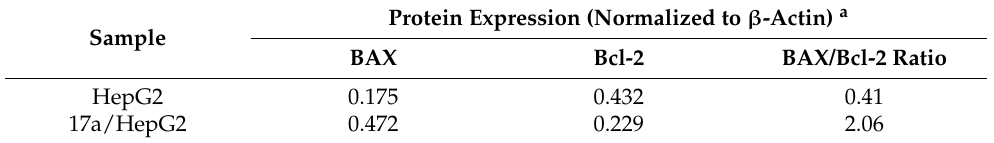
Table 6. The expression of BAX and Bcl-2 proteins in HepG2 cells after treatment with compound 17a .